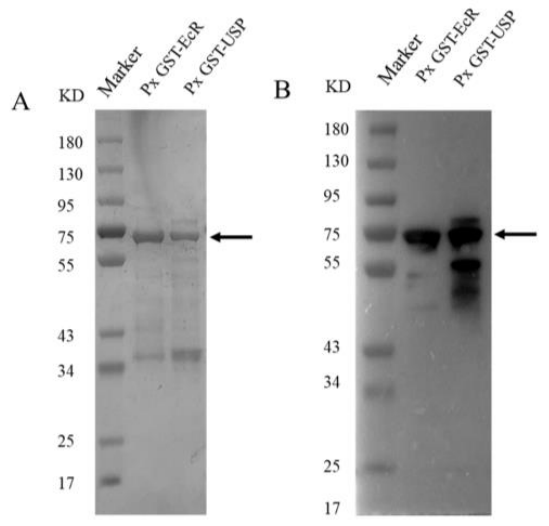
Figure 1. ( A ) Gel electrophoresis of target proteins ( Px GST − EcR and Px GST − USP); ( B ) Western blot of target proteins ( Px GST − EcR and Px GST − USP).